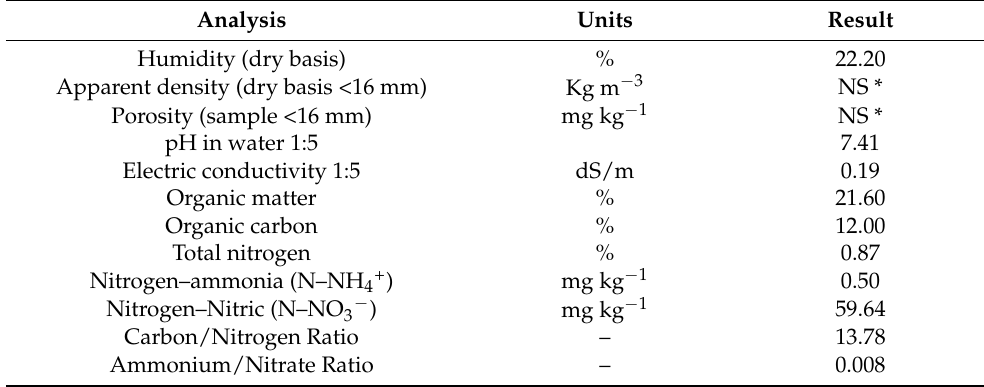
Table 2. Physical–chemical analysis of compost used for this study.